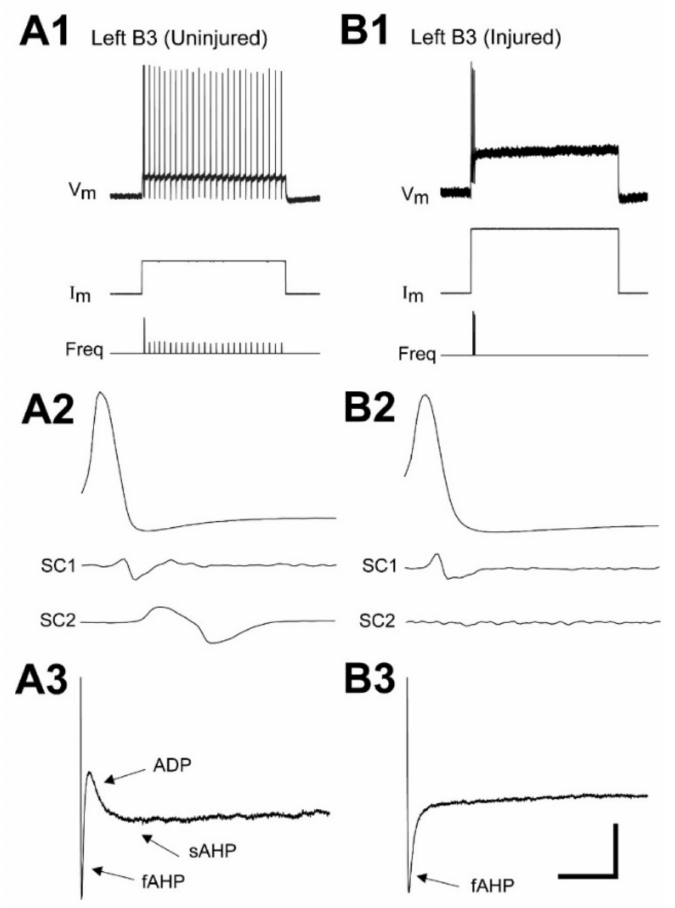
Figure 5. Interruption of ascending spinal-brain pathways does not contribute substantially to induction of injury-type firing patterns. Activity of ( A ) uninjured “B3” and ( B ) injured “B3” RS neurons (see Figure 1A) in different animals at 2 wks following lesions of the lateral spinal tracts and dorsal columns at 10% BL, which interrupt most ascending spinal-brain pathways (see Methods). ( A1,B1 ) Membrane potential (V m ), injected current (I m ), and instantaneous firing (spiking) frequency (Freq) during applied 2.0 s depolarizing current pulses. ( A2,B2 ) Evoked action potentials (top traces) and recordings from the spinal cord electrodes (SC1, SC2; see Methods) showing ( A2 ) orthodromic re- sponses rostral (SC1; see Figure 1B) and caudal (SC2) to the spinal lesion site for the uninjured neuron, and ( B2 ) only a response rostral to the lesion site (SC1) for the injured neuron. ( A3,B3 ) Afterpotentials following the repolarizing phase of action potentials: fAHP; ADP; and sAHP. Vertical/horizontal scale bar = ( A1,B1 ) 50 mV, 7.5 nA, 67 Hz/875 ms; ( A2,B2 ) 44.2 mV/2 ms; ( A3,B3 ) 4.4 mV/47 ms.